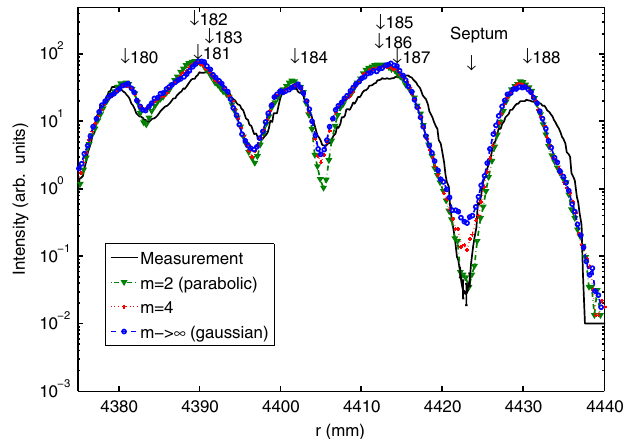
FIG. 8. The comparison of different initial beam distributions at the extraction probe, for a 2 mA